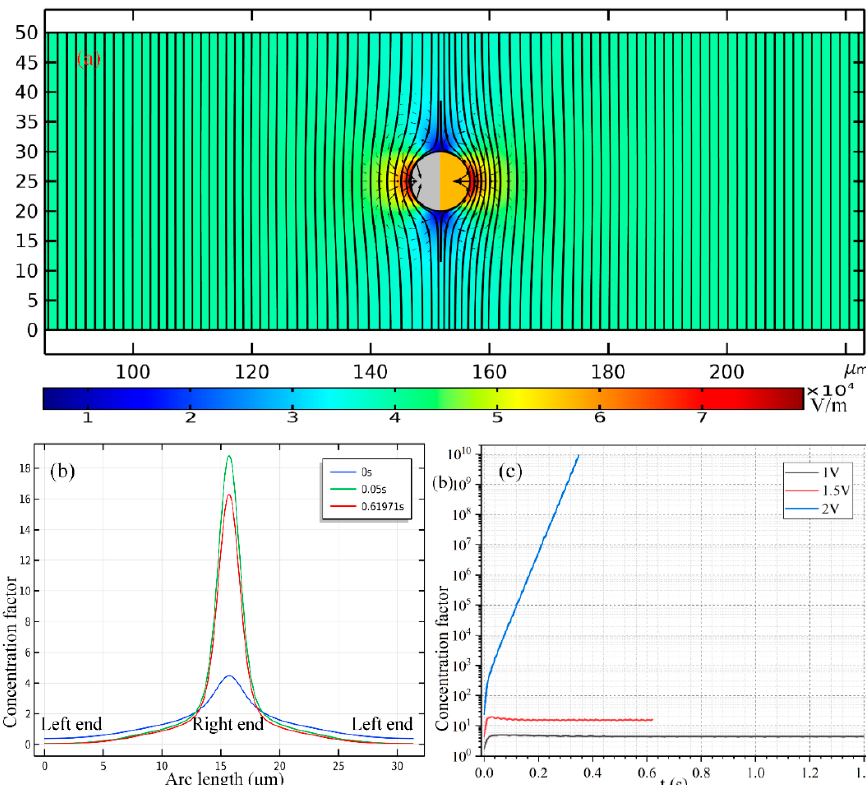
Figure 7. ( a ) The positive DEP velocity field of the nanoscale biomolecules dispersed in the liquid suspension around the Janus ME having an almost symmetric induced dipole moment in the low-frequency limit, which is on the order of 10 − 10 –10 − 7 m / s and can thereby be ignored in comparison with the electroconvective flow e ff ect. ( b ) The concentrating factor along the surface of the Janus PP at distinct time instants once the sinewave generator with an AC voltage of 1.5 V at f = 100 Hz is switched on. ( c ) The peak concentration factor of the target biomolecules on the surface of the Janus ME as a function of time for varying AC voltages at f = 100 Hz.